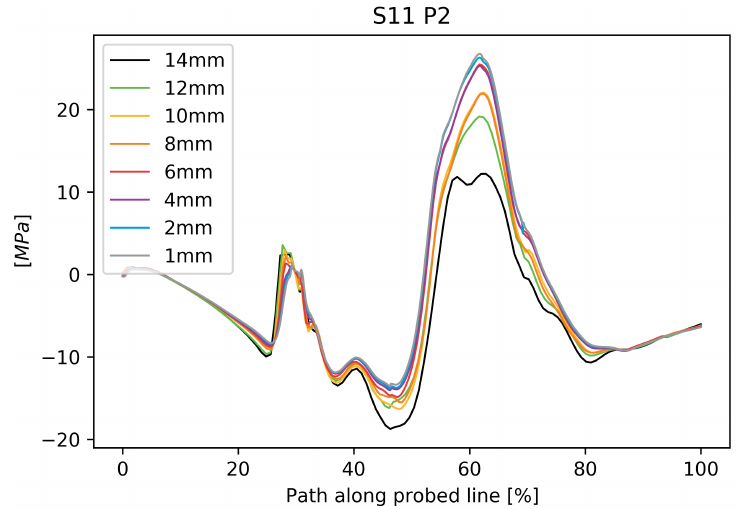
Figure 17. Convergence of first principle stress.